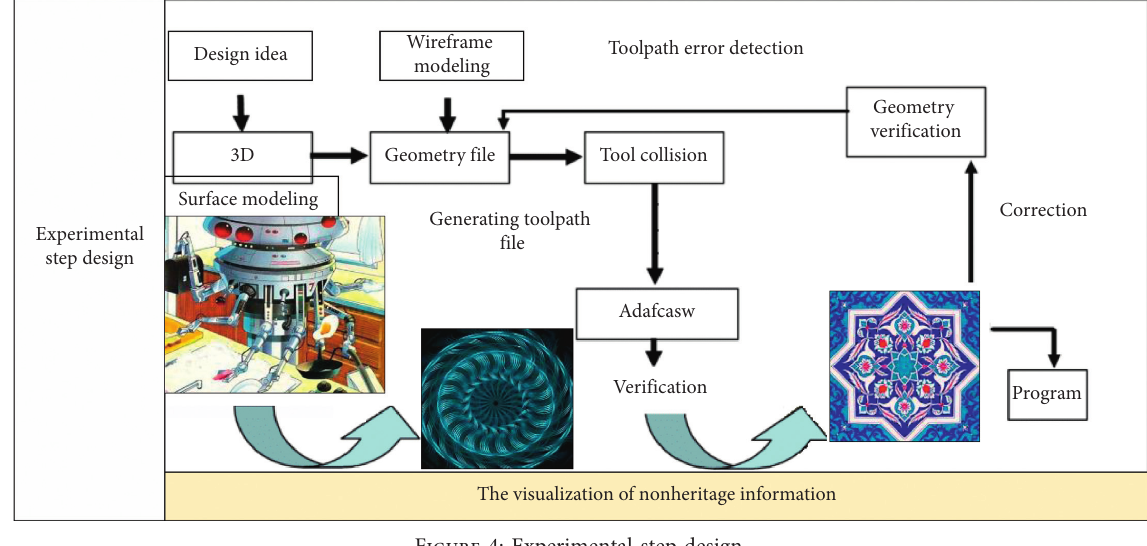
Figure 4: Experimental step design.